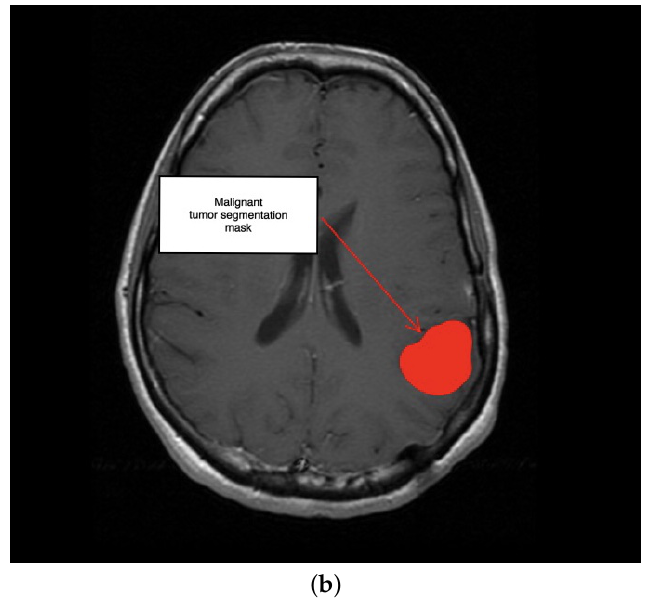
Figure 8. Experimental assessment, second patient. Segmentation with the proposed methodology ( a ) seeds localization, ( b ) results of the segmentation process, the red area indicated by SVM represents the pathologic tissue.